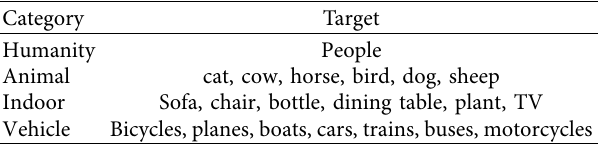
Table 1: Data object categories.